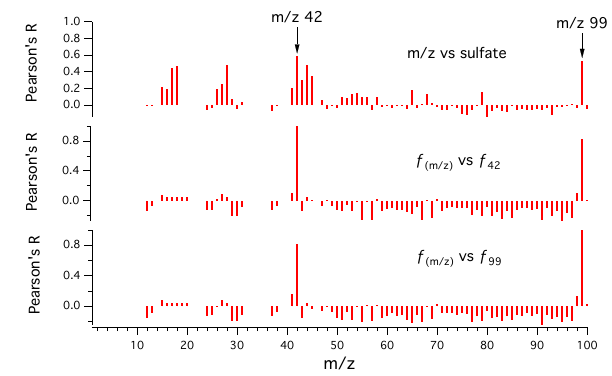
Fig. A2. Pearson R spectrum showing the variation of m/z concen- trations vs. the concentration of sulfate (top), the variation of the fraction of m/z 42 ( f 42 ) against the fraction of all other organic masses (middle), and the variation of the fraction of m/z 99 ( f 99 ) against the fraction of all other organic masses (bottom). These cor- relations were calculated for measurements made outside of